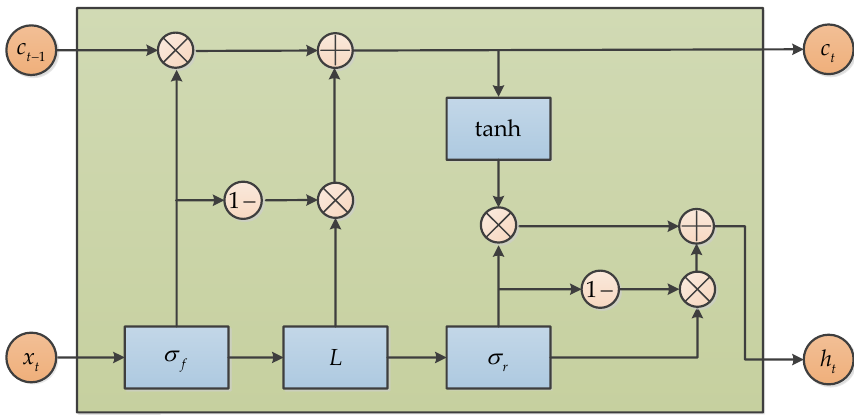
Figure 20. The structure of Simple Recurrent Unit.